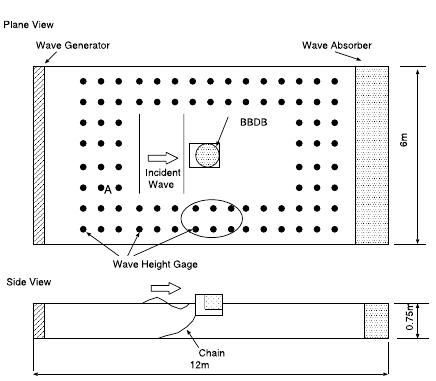
Fig. 4 Configuration of Wave gages and BBDB in the Wave Basin